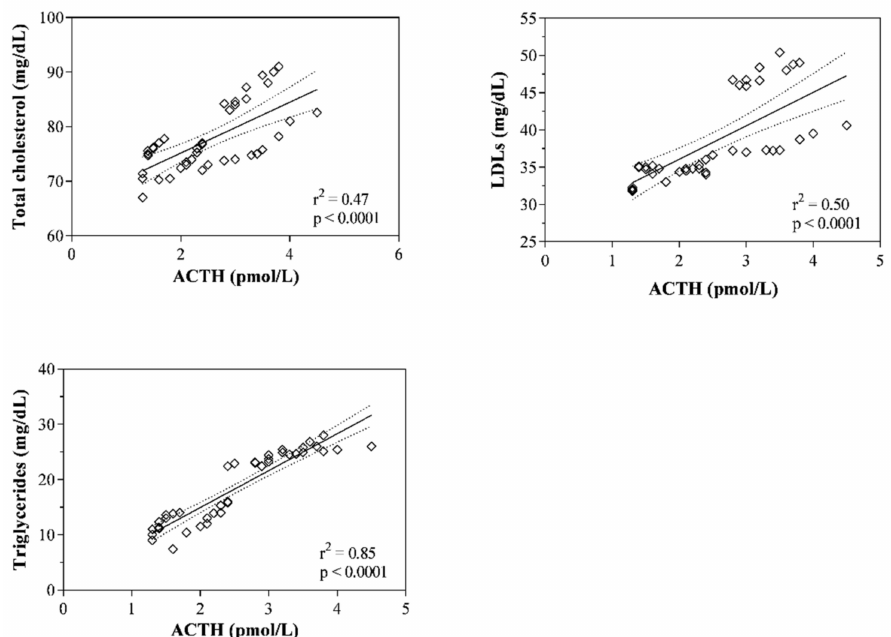
Figure 3. Linear regression values between the plasma adrenocorticotrophic hormone (ACTH) concentration and the levels of the serum parameters resulted statistically cor- related in pregnant mares (Group A) throughout the considered peripartum period (i.e., cortisol, leptin, mitochondrial uncoupling protein 1, UCP1; non-esterified fatty acids, NE- FAs; total cholesterol, low density and lipoproteins, LDLs; triglycerides; very-low-density lipoprotein fraction, VLDLs).